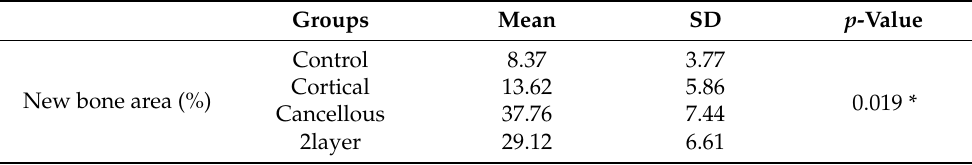
Figure 9. Histological images of experimental groups after 8 weeks. ( a ) Control, ( b ) Cortical, ( c ) Cancellous, and ( d ) 2layer groups. H&E: hematoxylin eosin staining, MT: Masson’s trichrome staining, OB: old bone, NB: newly formed bone, BM: bone graft material, arrow head: defect margin. Table 3. Mean and standard deviation (SD) of new bone area ( n =